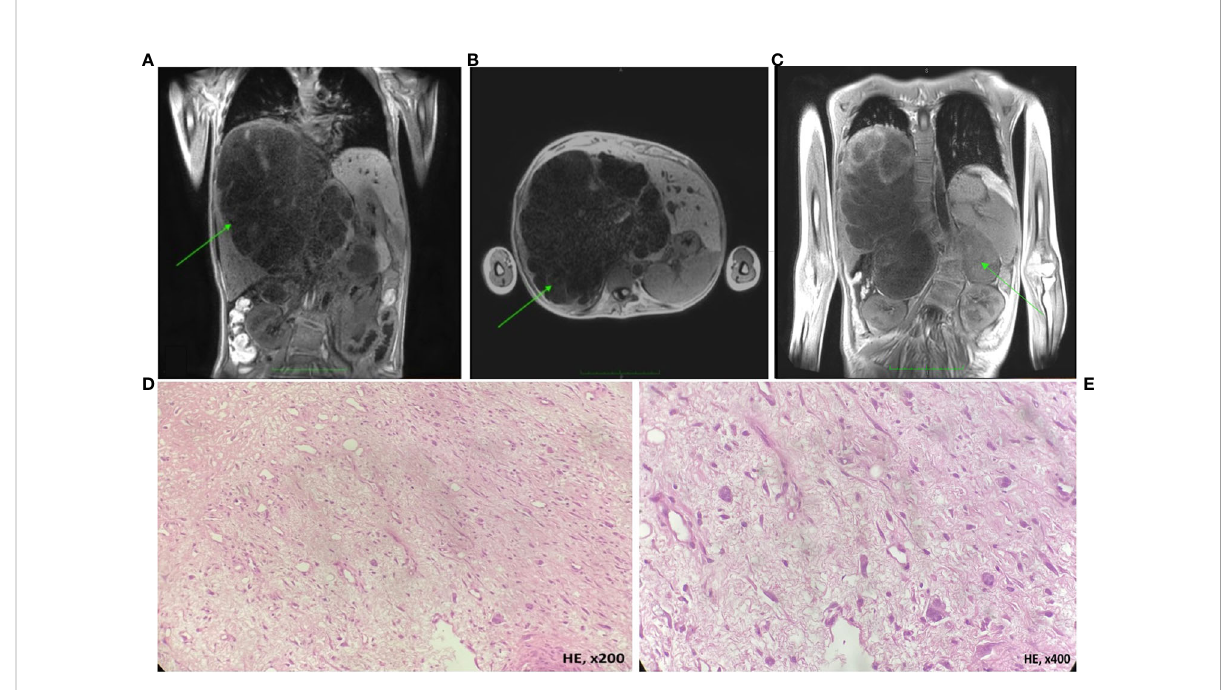
FIGURE 1 MRI of the abdominal cavity and morphological assessment of the liver tumor biopsy (UESL; hematoxylin-eosin, HE). (A, B) Images reveal a massive cystic formation in the right lobe of the liver, encompassing the segments S1, S5, S7, S8, and partially S4 and S6, measured 19 × 18.8 × 19.3 cm (3580 cm 3 ), with the signs of periportal in fi ltration. The inferior vena cava at the level of tumor mass is compressed and pushed aside. The right and middle hepatic veins, as well as the arteries, pass through the mass. The portal vein at the level of the bifurcation and its right branch pass through the mass. Classi fi ed as PRETEXT stage III C1, E0, H0, F1, N0, M0, P2, V2; (C) a T2-weighted image shows a solitary tumor node, 8 × 6 × 8 cm. Microscopically the lesion was presented by short bundles and sheets of spindle-shaped or irregularly shaped cells and collagenous stroma with myxomatous areas (D) . Neoplastic cell exhibited moderate nuclear-cytoplasmatic ratio, nuclei varied in site and shape from ovoid to polygonad. The cytoplasm of tumor cell was eosinophilic or optically empty (E)